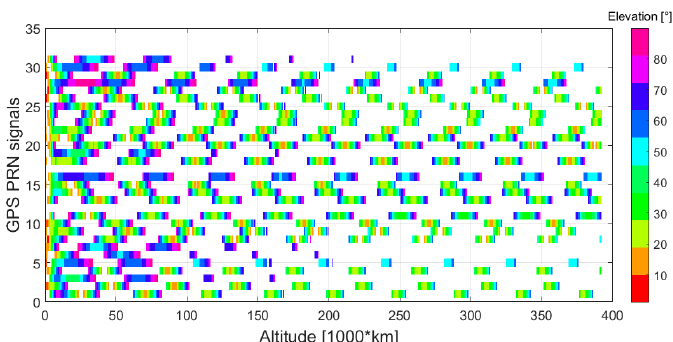
Figure 1. Elevation angle of the global positioning system (GPS) antenna pattern from which the signals are received, for the assumed moon transfer orbit (MTO) in Section 2.1.